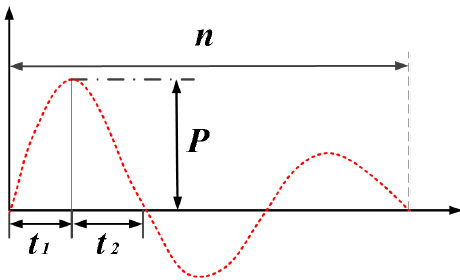
Figure 3. Typical impulse response of a nonlinear